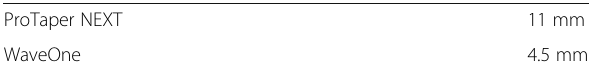
Table 2 showing the displacement during bending of both files